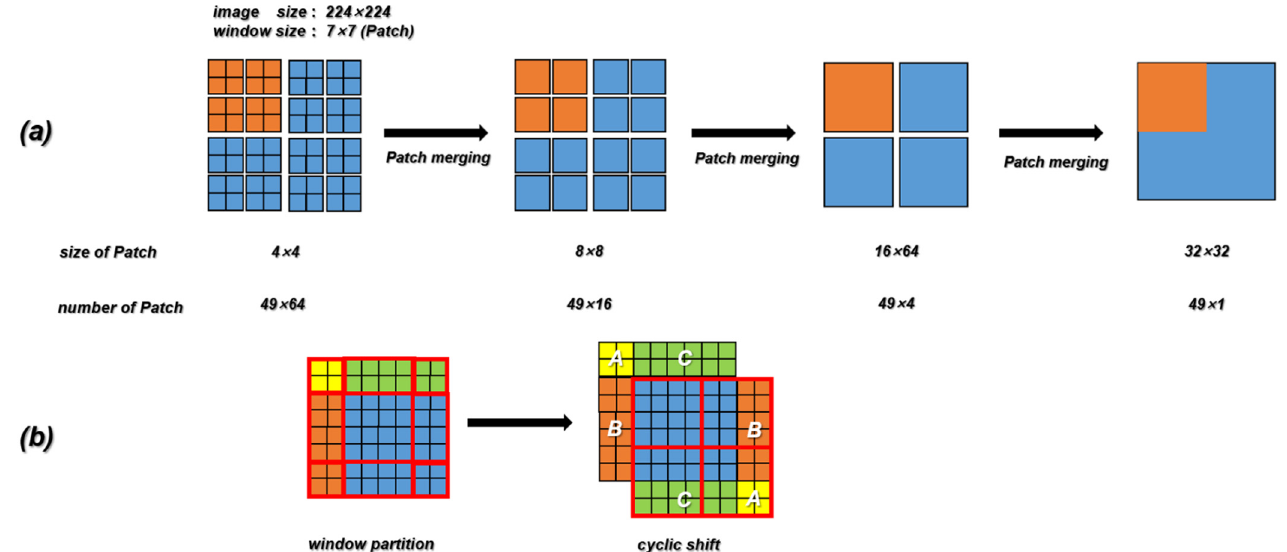
Figure 5. ( a ) The downsampling process of Swin-Transformer. ( b ) Schematic diagram of the SW-MAS operation flow. A, B and C are the regions which need to be moved in the previous feature map.